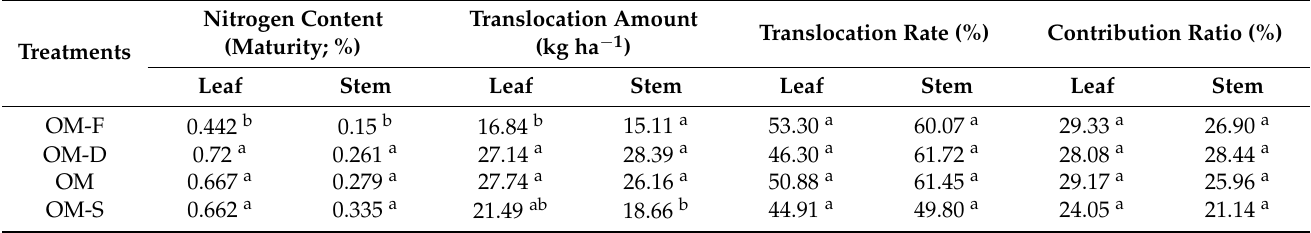
Figure 4. The vertical distribution of N content of maize leaf ( a , c ) and stem ( b , d ) at silking stage in 2017 ( a , b ) and 2018 ( c , d ), respectively. “a, b” indicate significantly different at the 5% probability level. Table 1. Effects of different cultivation modes on nitrogen transport in maize in 2019.